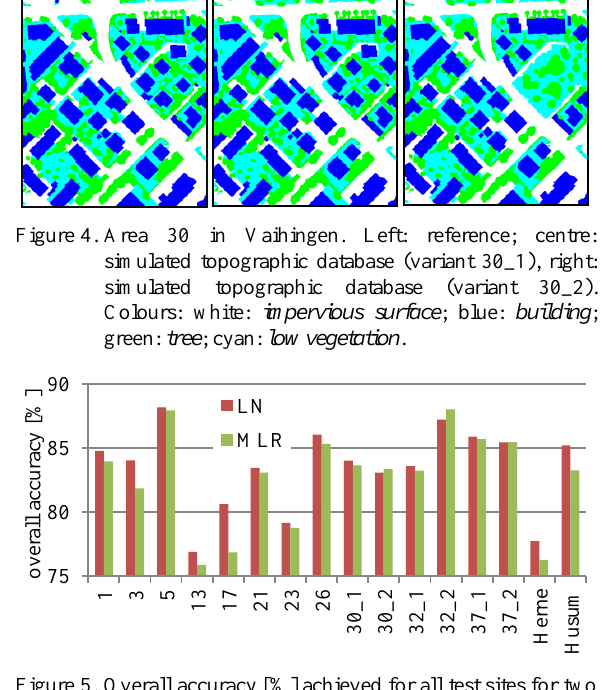
Figure 3. Median of absolute differences between the estimated and the true elements of the transition matrix (LN).